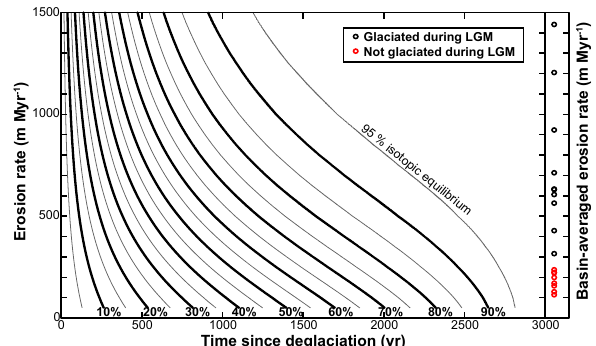
Figure 5. Predicted evolution of landscapes toward isotopic evolu- tion after deglaciation. Black and grey lines denote 10% and 5% contour intervals, respectively. Basin-averaged erosion rates from the Olympic Mountains are shown on the right. Basins marked in red were not glaciated during the Last Glacial Maximum